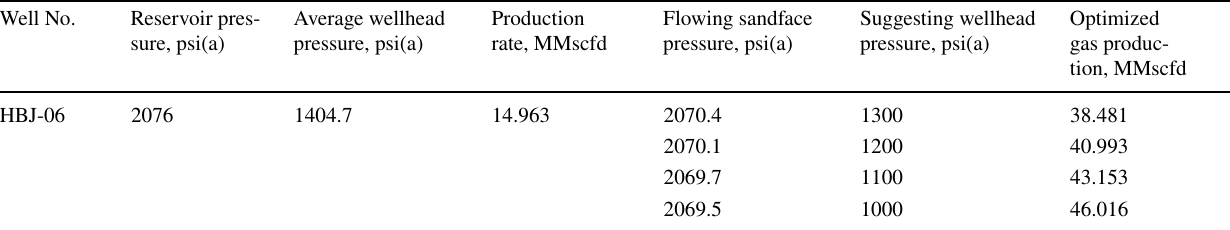
Table 5 Evaluation of natural gas production results of the HBJ-06, Habiganj gas field, Bangladesh Well No.